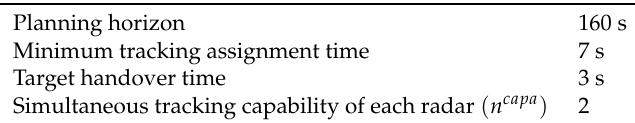
Table 3. Parameter set for local-scale model